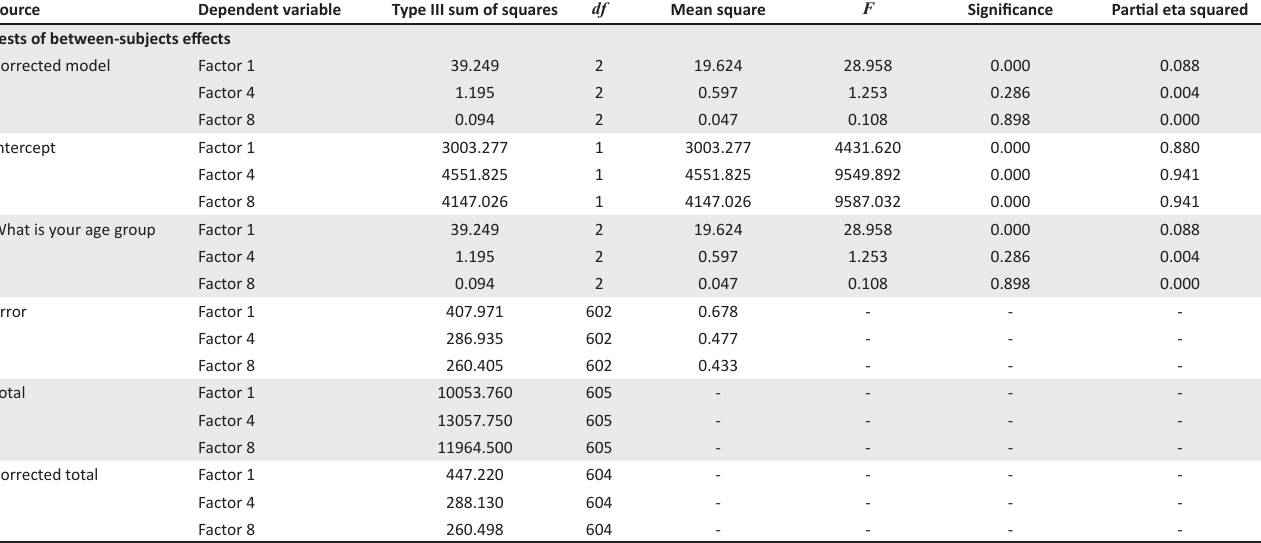
TABLE 8: Multivariate analysis